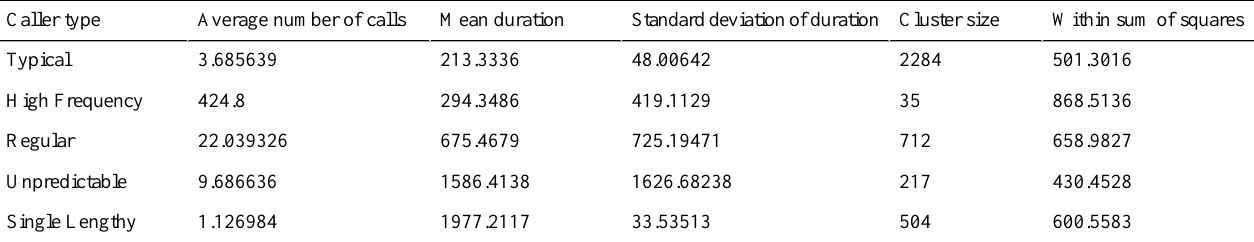
Table 3. Cluster centroids of callers within the Pre–COVID-19 period.